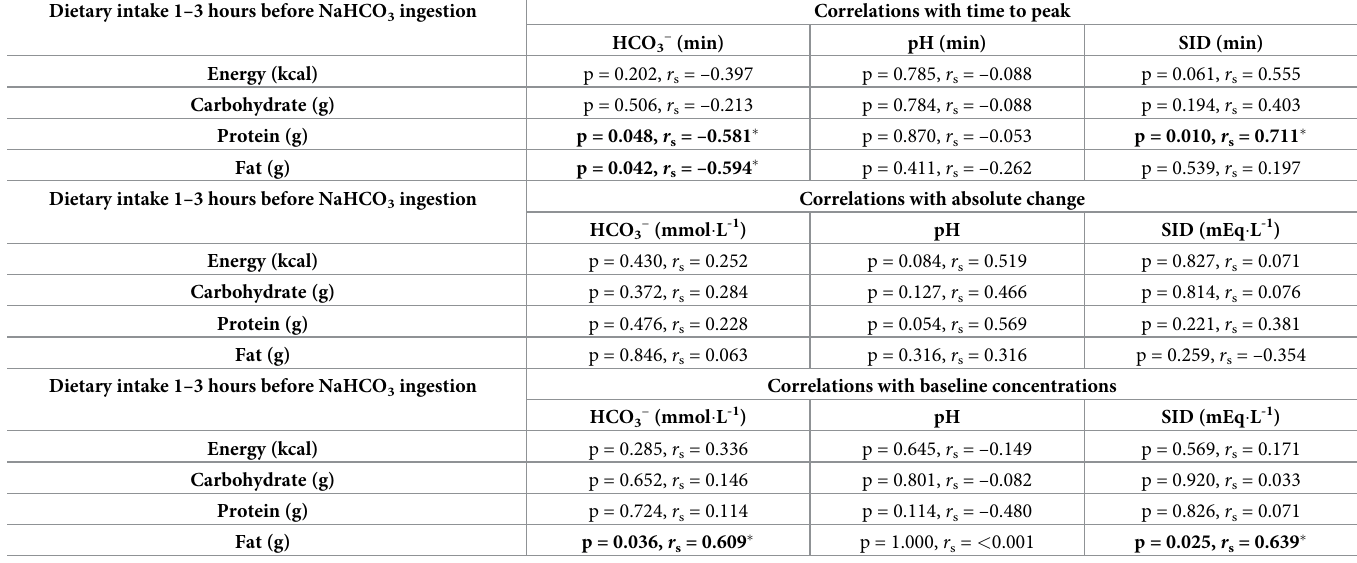
Table 4. The associations between the composition of the pre-ingestion meal with the time course changes in acid-base balance variables following NaHCO 3 ingestion. Dietary intake 1–3 hours before NaHCO 3